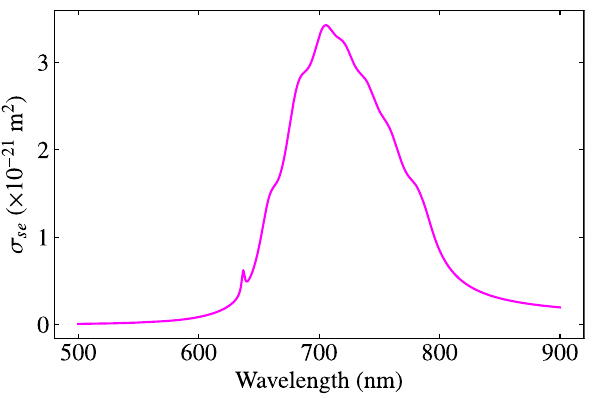
Figure 11: Spectrum of the nitrogen-vacancy (NV) centre from our sample by green wavelength pumping without any cavity mirrors. Stimulated emission of our sample as a function wavelength. At ∼ 721 nm, σ ∼ 3 . 22 × 10 − 21 m − 2 se